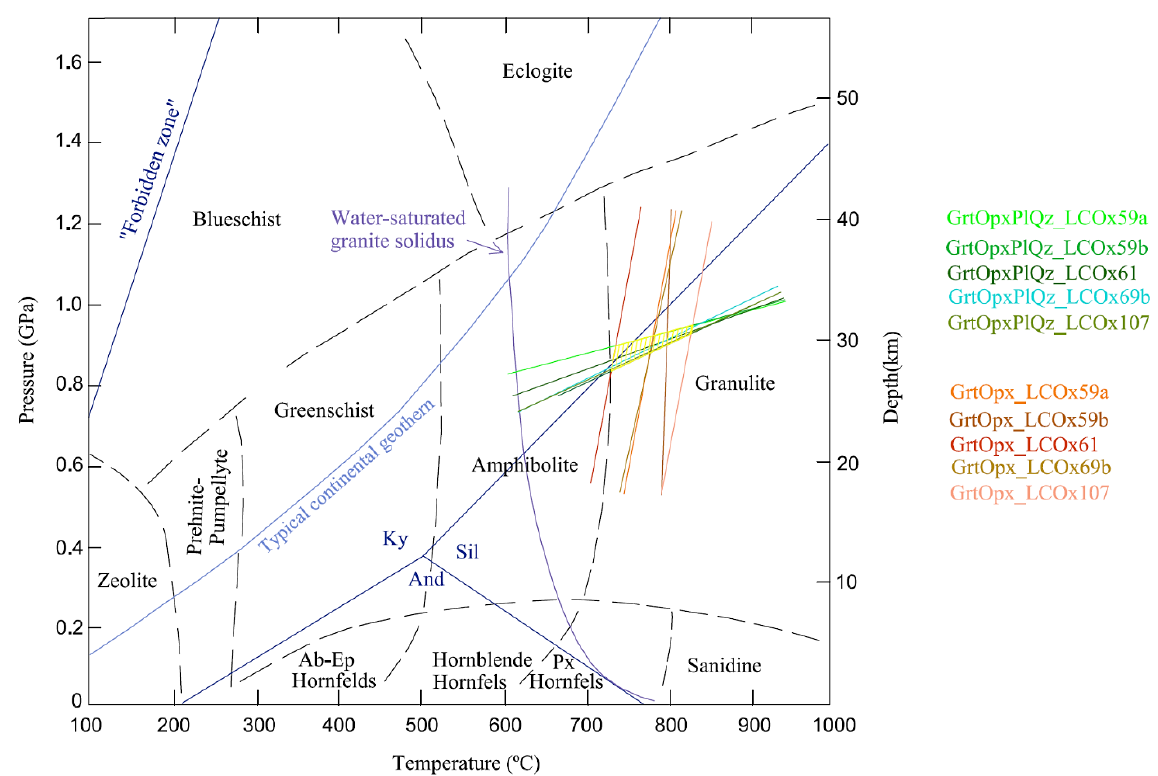
Figure 8. P-T diagram including the intersection between the Grt-Opx-Pl-Qz geobarometer data obtained with two inputs of T (800 °C and 900 °C) and the two Grt-Opx geothermometer P inputs (0.9 and 1.0 GPa) in the same samples. The obtained stability field is marked in a yellow shade.